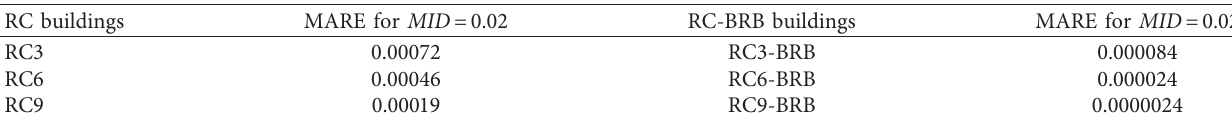
Table 4: Comparison of the mean annual rate of exceedance (MARE) values for the RC and RC-BRB buildings for a MID value equal to 0.02. RC buildings MARE for MID � 0.02 RC-BRB buildings MARE for MID � 0.02 RC3 0.00072